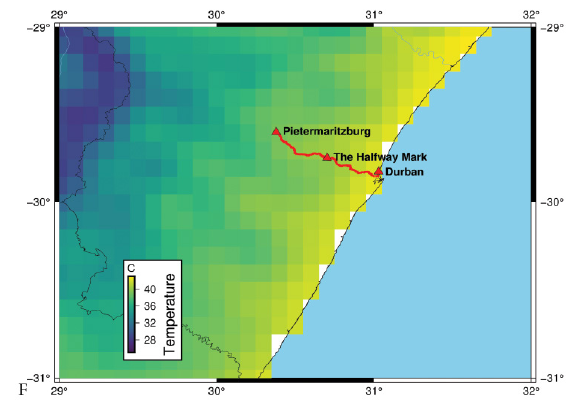
ERA5-UTCI (Universal Thermal Comfort Index) values and predicted associated physiological stress response 14-17